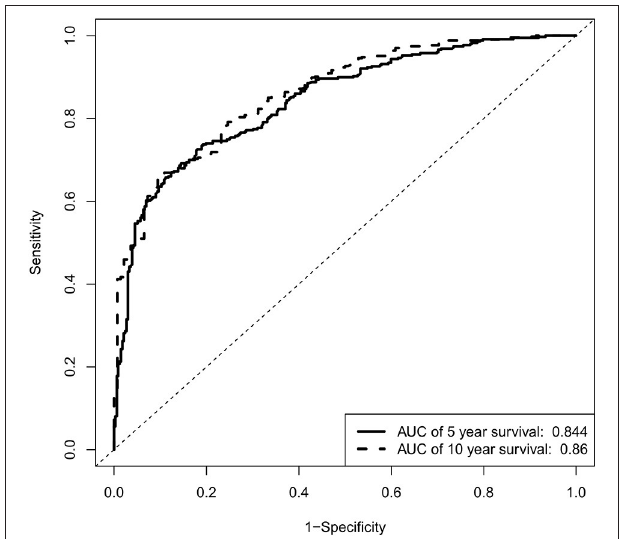
FIGURE 3 | ROC curves for validating nomogram model.